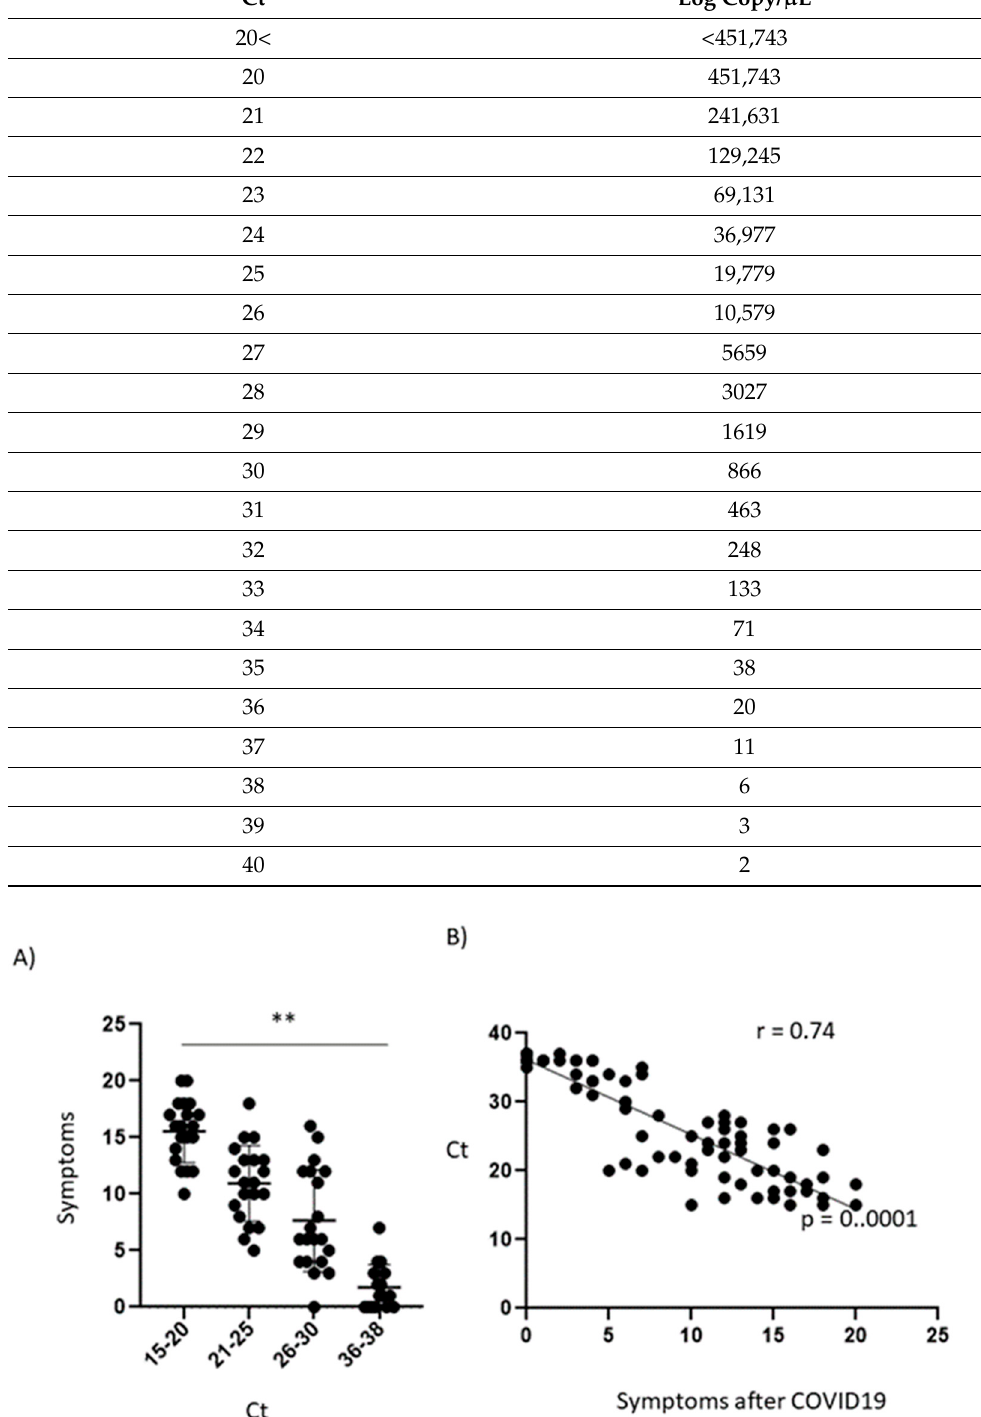
Figure 3. Association between the number of symptoms and Ct value and its correlation. ( A ) Number of symptoms present post-COVID19 versus the Ct value n = 76 (40 men and 36 women). The statistical test used was Student’s t test. The statistical difference is p < 0.001 **, ( B ) Pearson correlation (95% confidence level) and is reported as “r” and the probability value as “ p ”. n = 76.